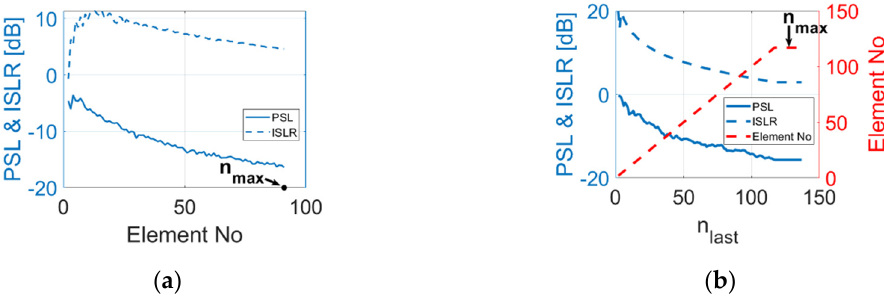
Figure 2. PSL and ISLR performance of ( a ) random array configuration and ( b ) sunflower array configuration with respect to number of elements within the array.